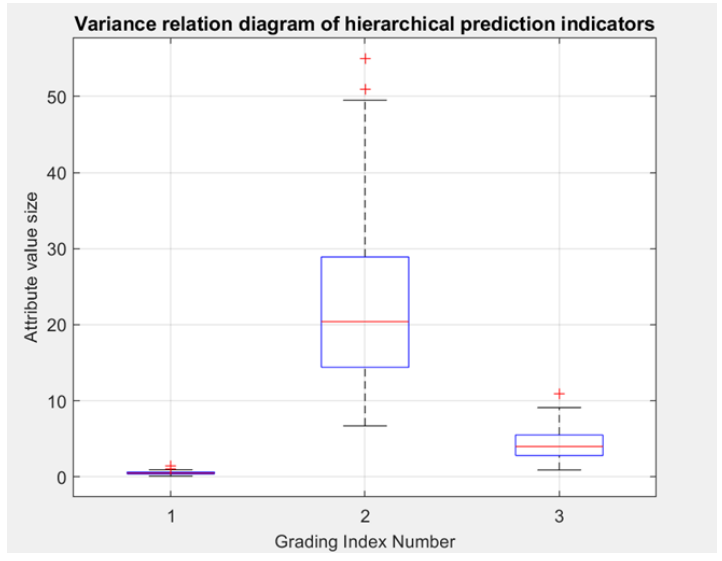
Figure 1. Variance relation diagram of hierarchical prediction indicators. Table 3. ANOVA visualization table of the test